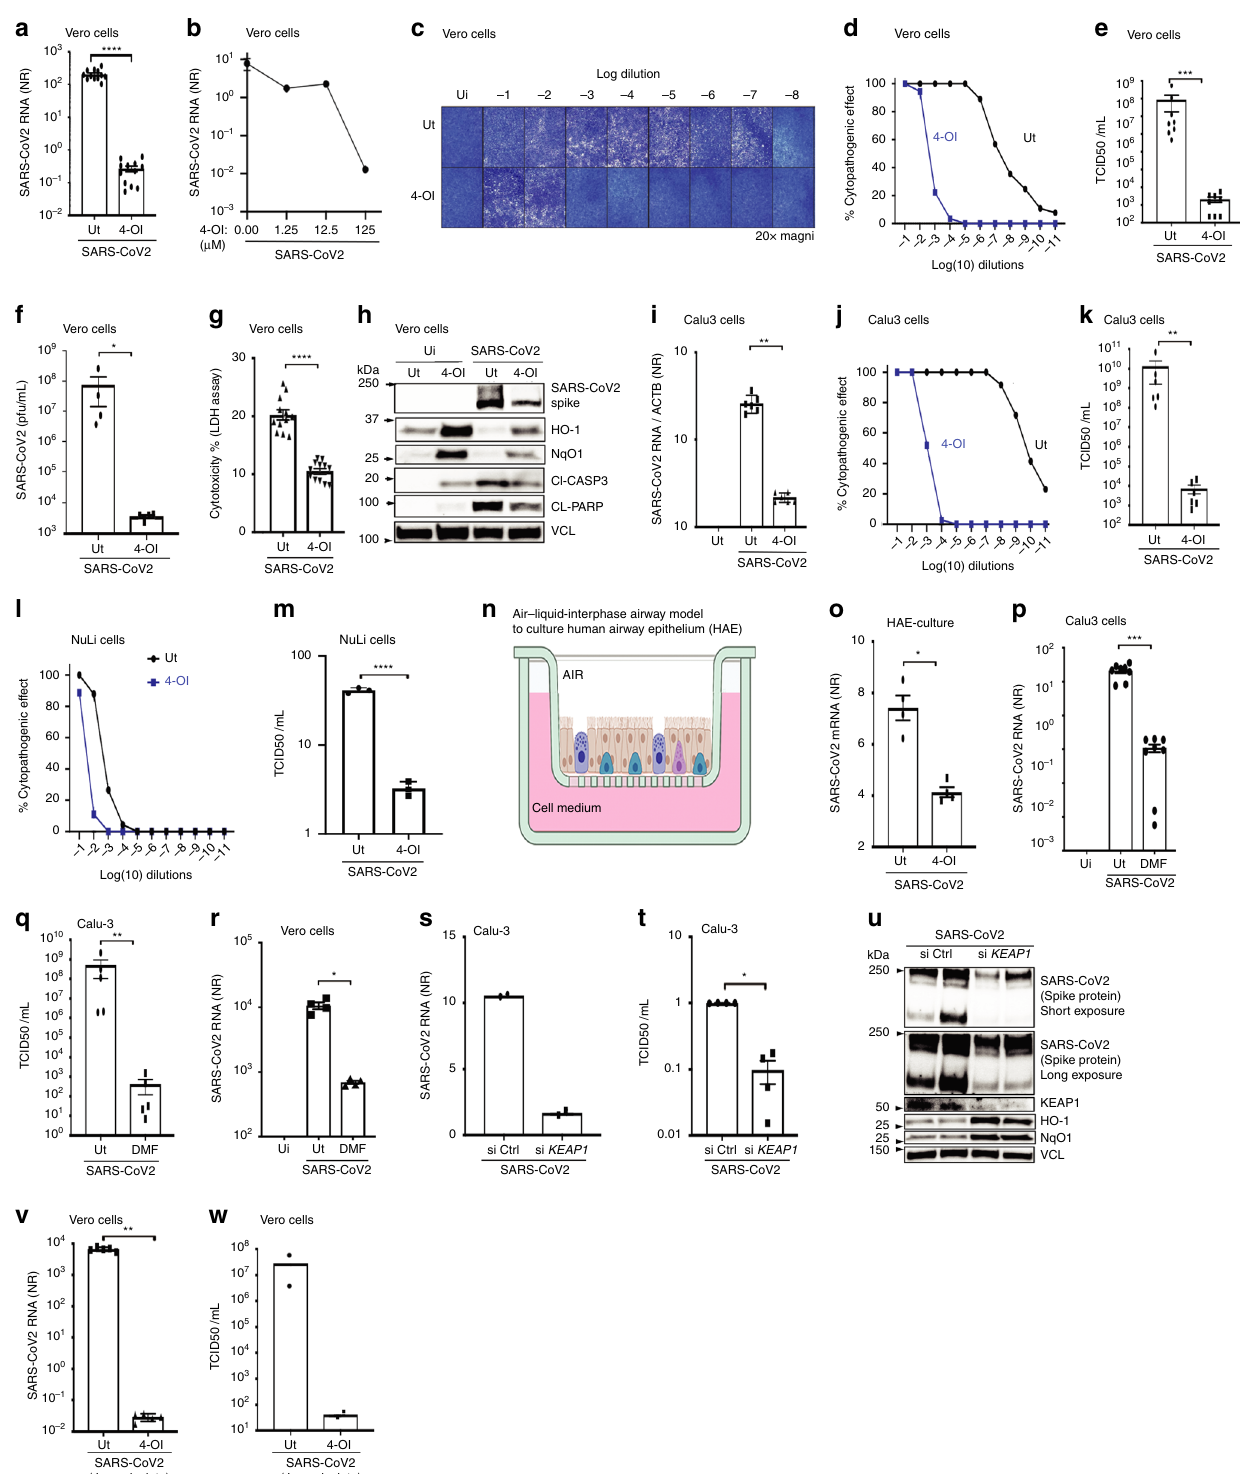
These data demonstrate that NRF2 inducers 4-OI and DMF inhibit SARS-CoV-2 replication by a magnitude of several logs. 4-OI broadly inhibits viral replication through an IFN- independent pathway . The antiviral effect of 4-OI was not restricted to SARS-CoV2 but also extended to other human pathogenic viruses. Using the human keratinocyte cell line HaCaT, 4-OI also inhibited HSV1 and HSV2 multiplication, as